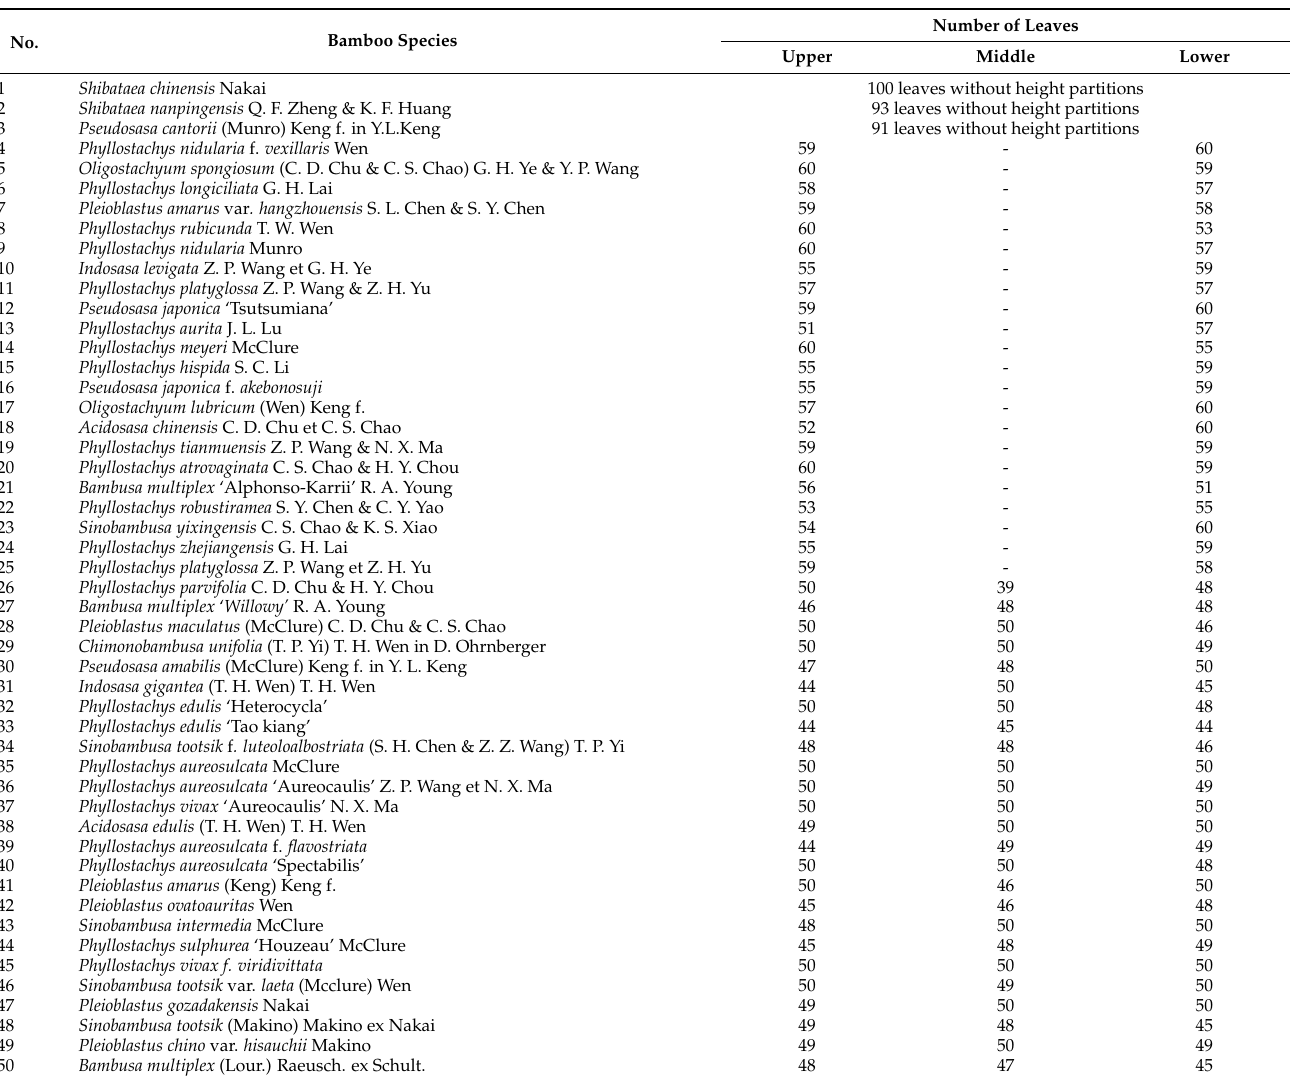
(3) at least 100 leaves were randomly sampled from more than 20 crowns without height partition for crown heights of less than 1 m. Table 1. Details of sampled leaves of 50 bamboo species. Crowns were evenly divided into upper, middle, and lower parts for crown height no less than 2 m. If a crown’s height was between 1 and 2 m, the crown was evenly divided into upper and lower parts. Height partition was not considered for crown heights of less than 1 m. Leaves of the 50 bamboo species were fewer than the initial number of samples because low-quality scanned images were discarded, such as those of the folded or overlapped